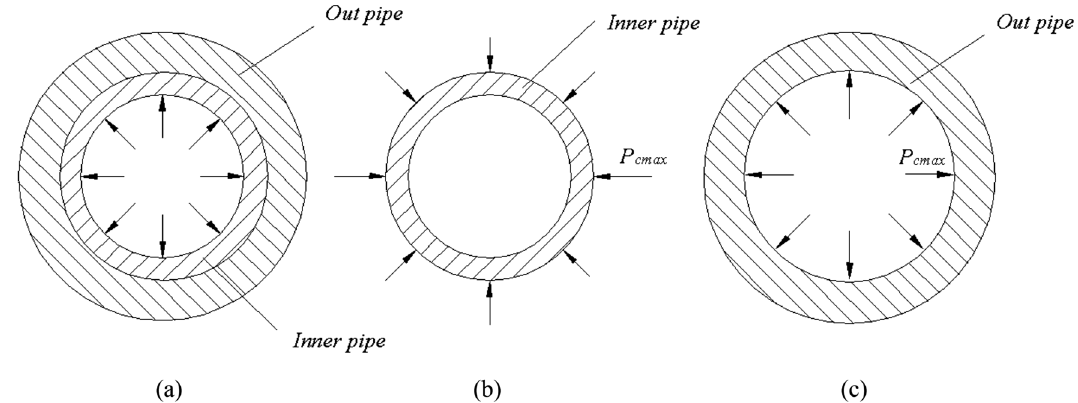
Fig. 3 Stress state of composite pipes in spin